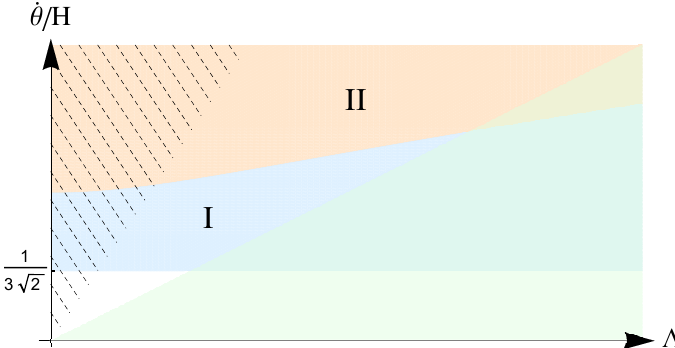
Figure 3 . Parameter space for the (cid:30) - h system with (cid:21) = 0 : 01. The green area is the (cid:13)at-decoupling p limit with _ (cid:18)= (cid:3) < (cid:21) . The meshed area is incompatible with the Naturalness condition _ (cid:18)= (cid:3) < 1. p The blue (orange) area is the region satis(cid:12)es the heavy Higgs condition _ (cid:18)=H > 18 with a weak- mixing (strong-mixing) (cid:22)=H < 1 ( (cid:22)=H > 1), respectively. One can impose the condition _ (cid:30)= (cid:3) 2 < 1 to suppress the higher-order corrections from ( @ ) n = (cid:3) n to the system (3.1). In terms of (cid:18) = (cid:30)= (cid:3), the Naturalness condition, namely (cid:22) (cid:30) p _ (cid:18) < (cid:3), includes all the (cid:13)at-decoupling region _ (cid:18) < (cid:21) (cid:3) since the perturbativity asks (cid:21) < 1. As shown in (cid:12)gure 3, a heavy Higgs (cid:12)eld can be realized in the curvelinear limit